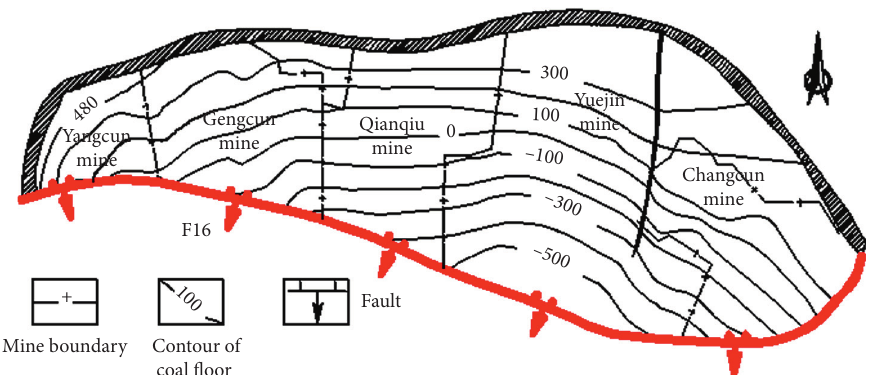
Figure 1: Mine distribution of Yima coalfield.